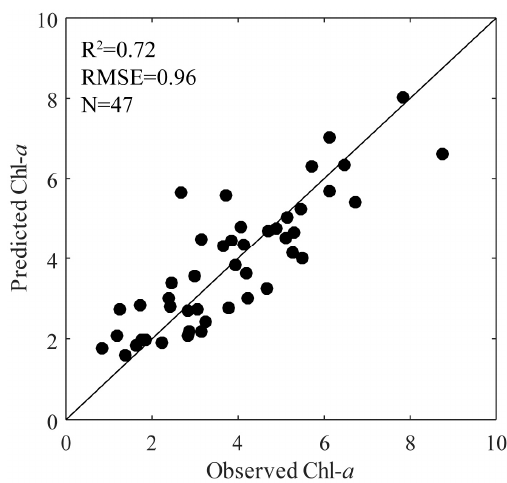
Figure 12. Validation of iterative stepwise elimination partial least squares (ISE-PLS) method using lower chlorophyll a (Chl- a ) concentration dataset (station 4 not included).